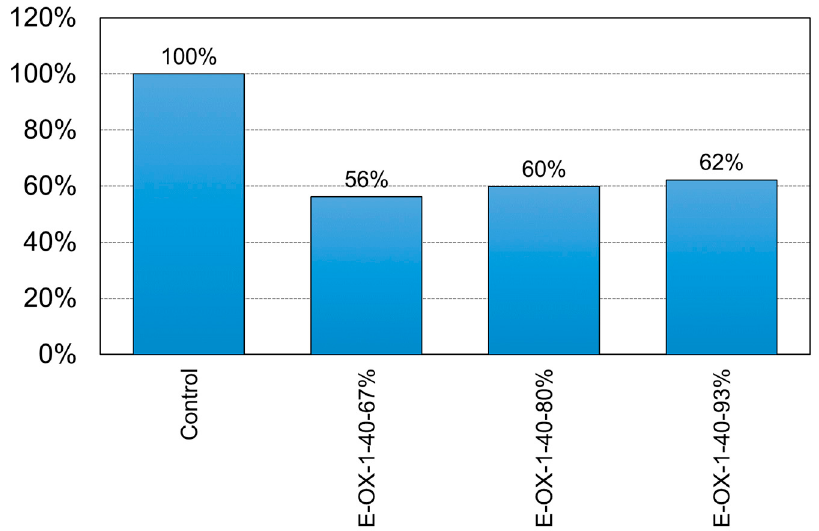
Figure 17. Ductility of NSM specimens (Bond length).